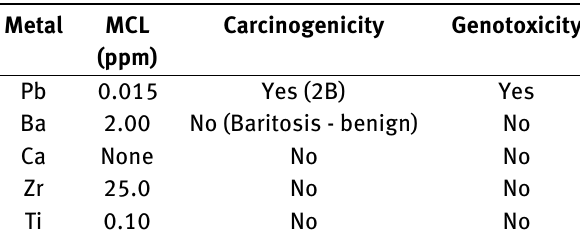
MCL: Maximum Containment